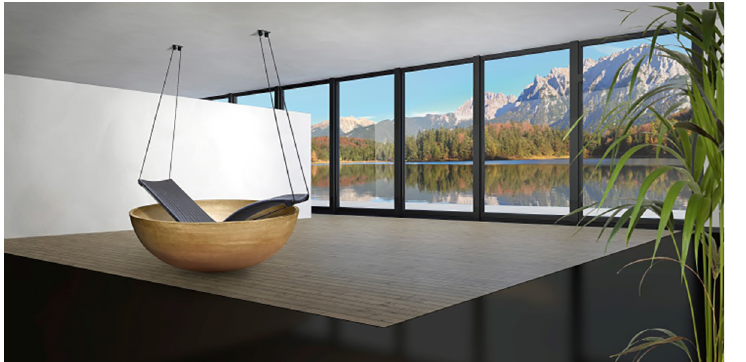
Fig 3. Singing bowl with a